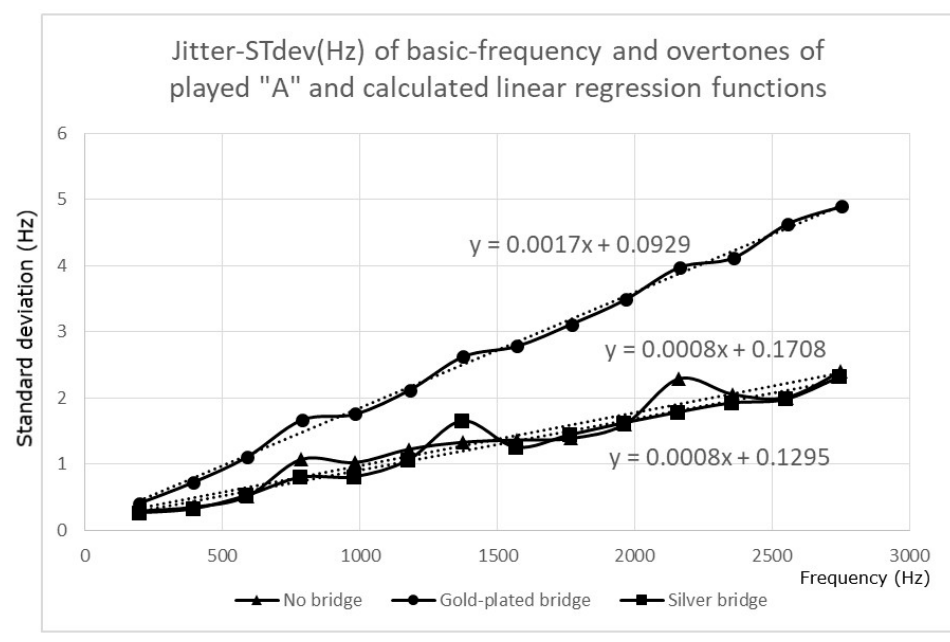
Figure 5. Standard deviation of the frequency Jitter of the basic frequency and the related overtones (harmonics) of a played tone-A (196 Hz)on the saxophone with and without metal bridges mounted. The dashed lines represent the linear regression of the displayed data, with their respective linear function (see Material and Methods). The upper displayed function represents the linear regression of the data of the gold-plated bridge; the lowest function represents the regression of data of the silver bridge.